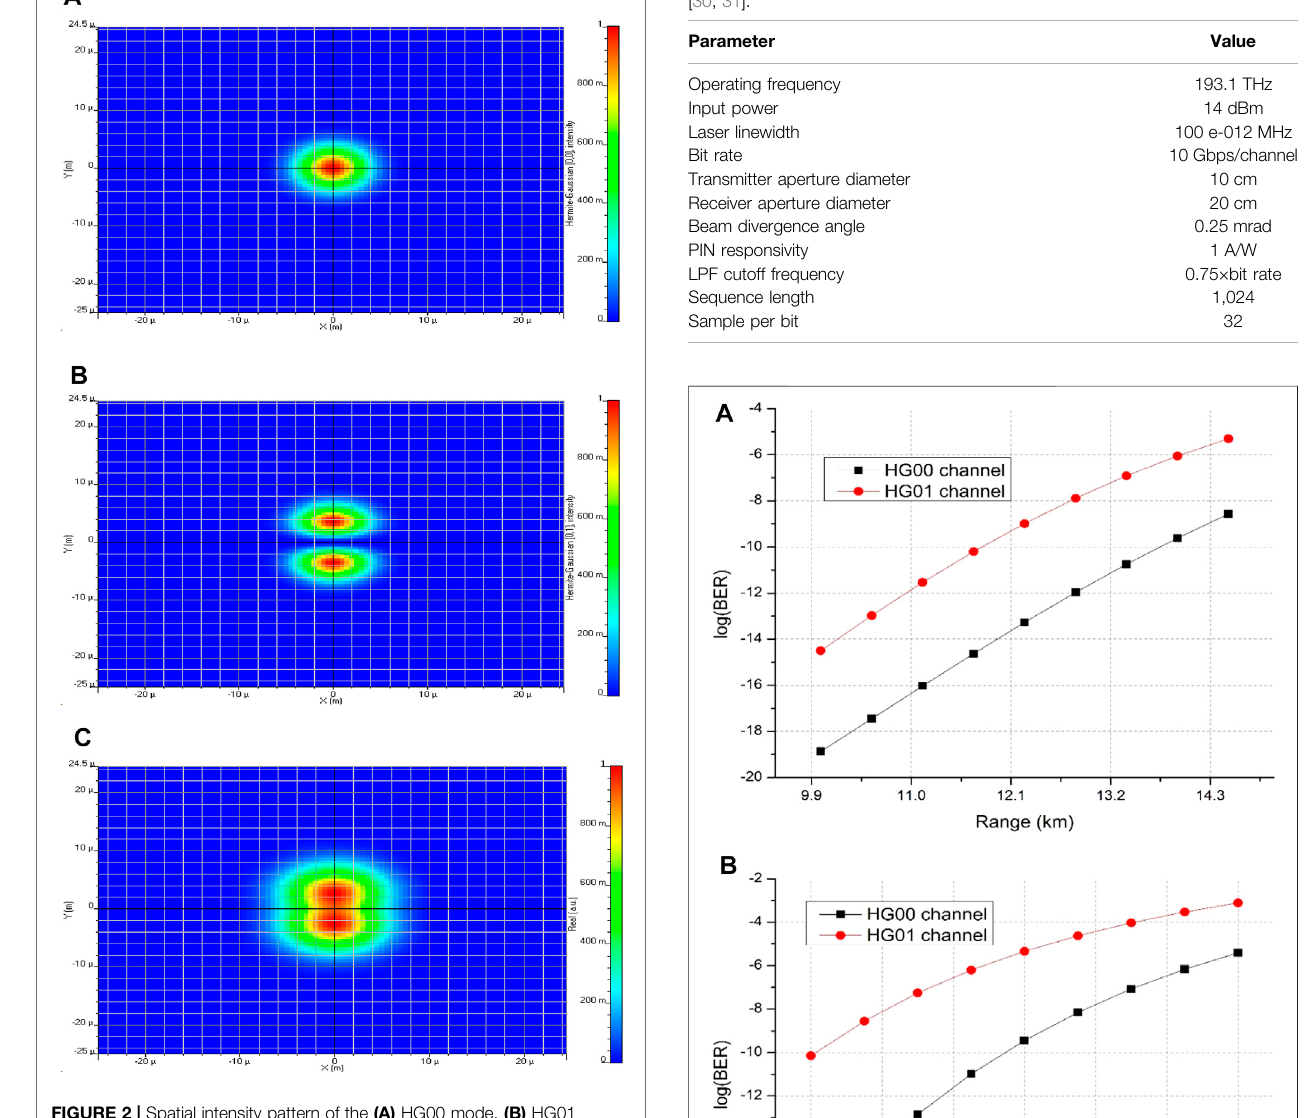
TABLE 2 | Simulation parameters considered for the proposed link design [30,